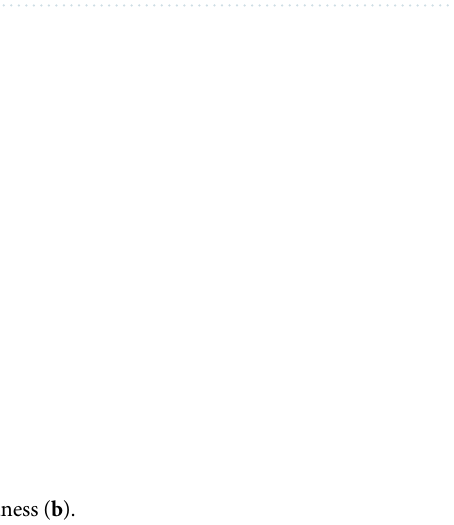
Figure 1. Test device: ( a ) Freeze–thaw test device; ( b ) Schematic diagram of freeze–thaw test for soil samples; ( c ) Particle Image Processor.